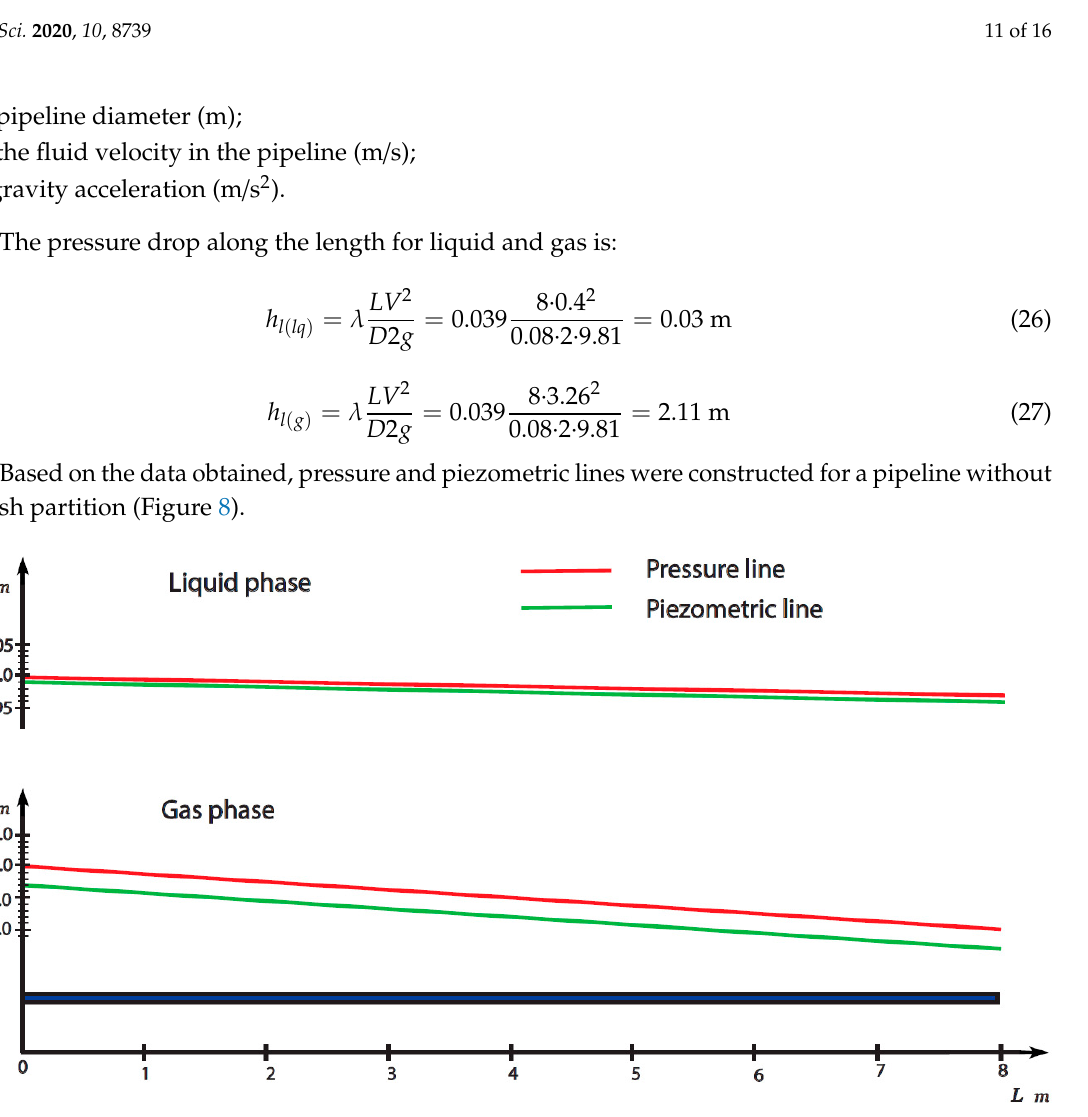
Figure 8. Pressure and piezometric lines for gas and liquid phases (pipeline without mesh partition).